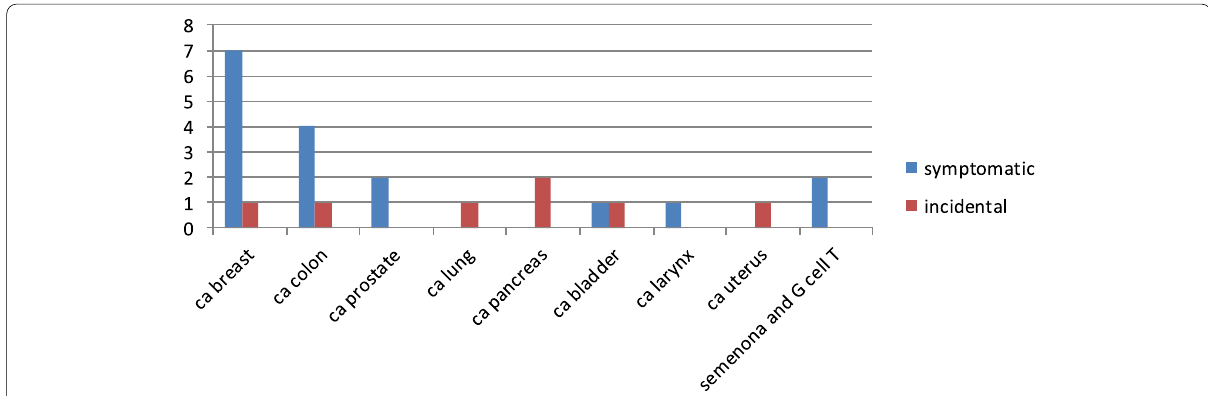
Fig. 1 The incidence of symptomatic and incidental PE in different